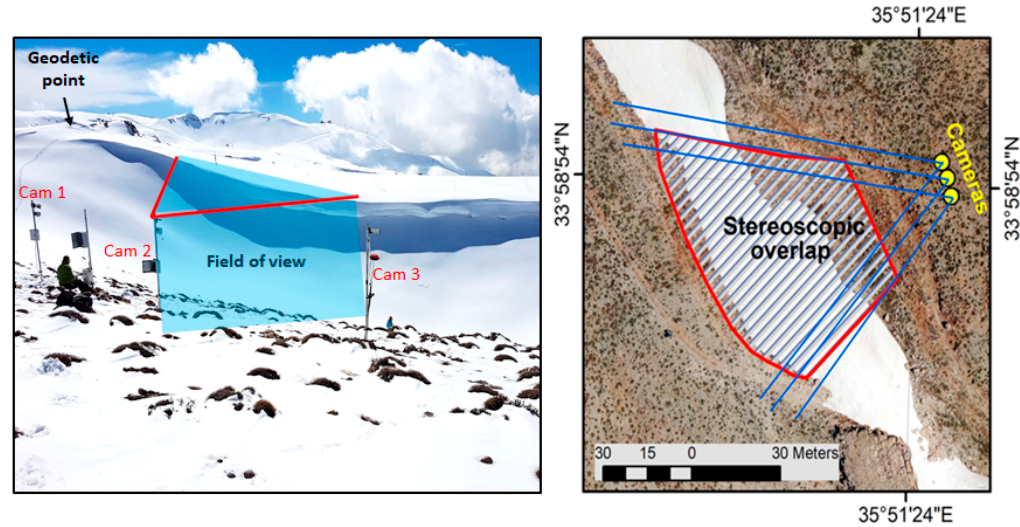
Figure 2. Setup: ( a ) Terrestrial view of the setup; ( b ) Drone ortho-image of the study area, taken on 24 April 2018 with 100 m as flight altitude.